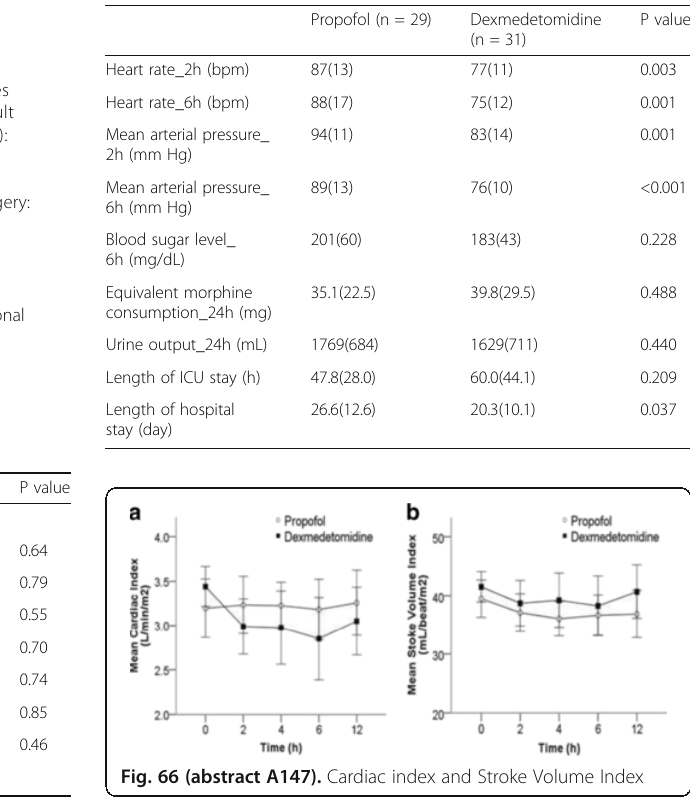
Table 54 (abstract A147). Hemodynamic Parameters and Patient Outcomes